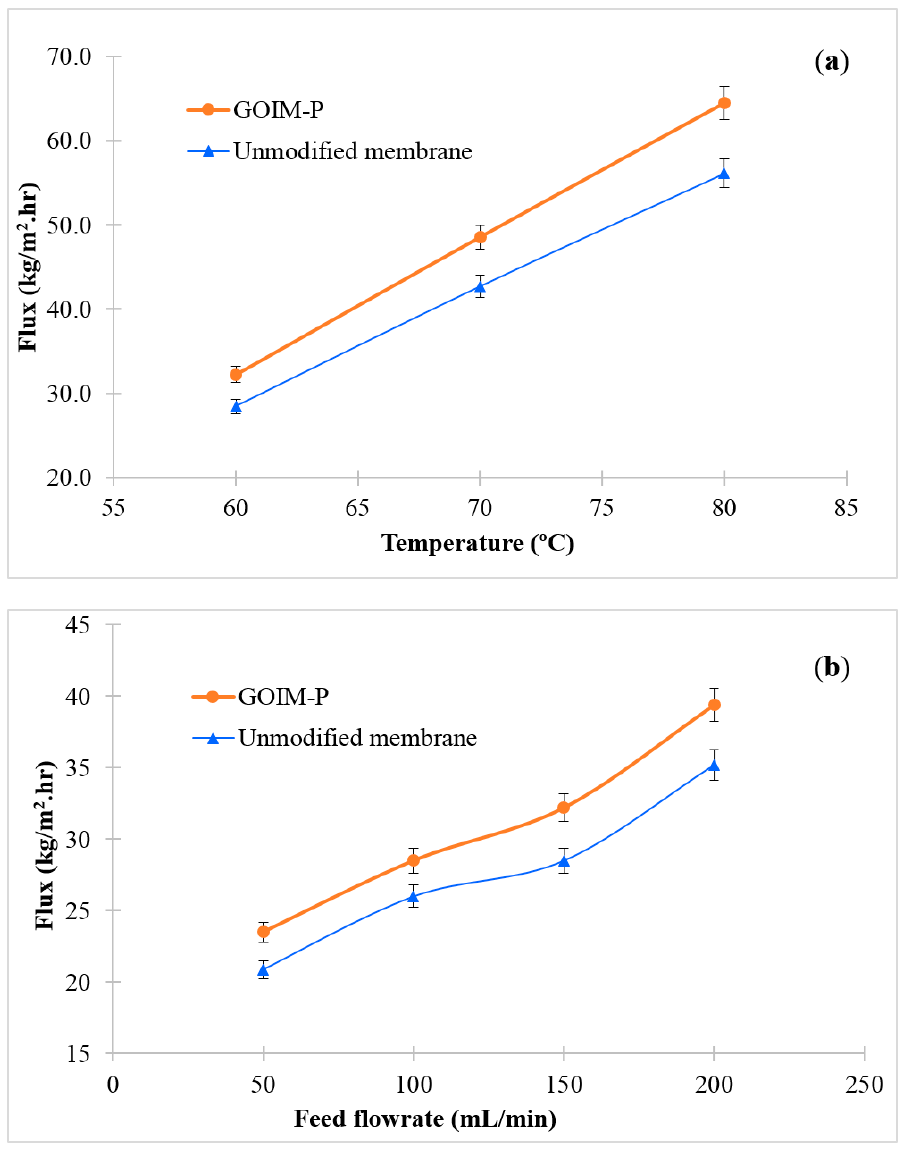
Figure 6. Effect of ( a ) temperature on water vapor flux at a feed flow rate of 150 mL/min; and, ( b ) feed flow rate on water vapor flux at feed temperature of 60 °C.